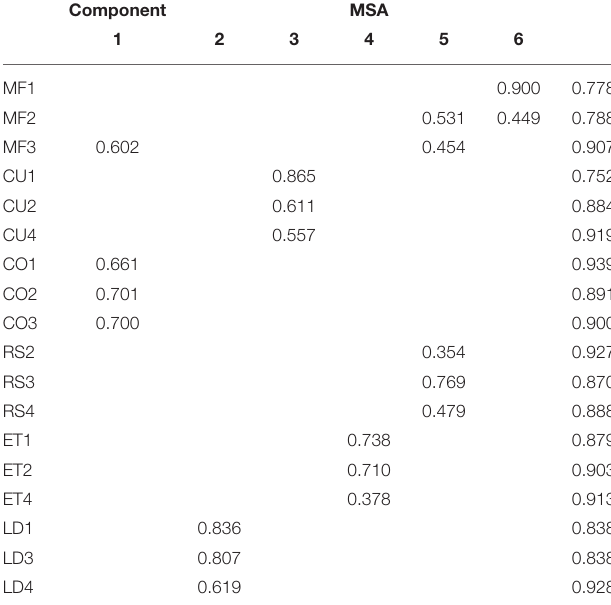
TABLE 4 | Principal component analysis (PCA) on Skills dimension items (12) for the CCI-21 36 items version. Component